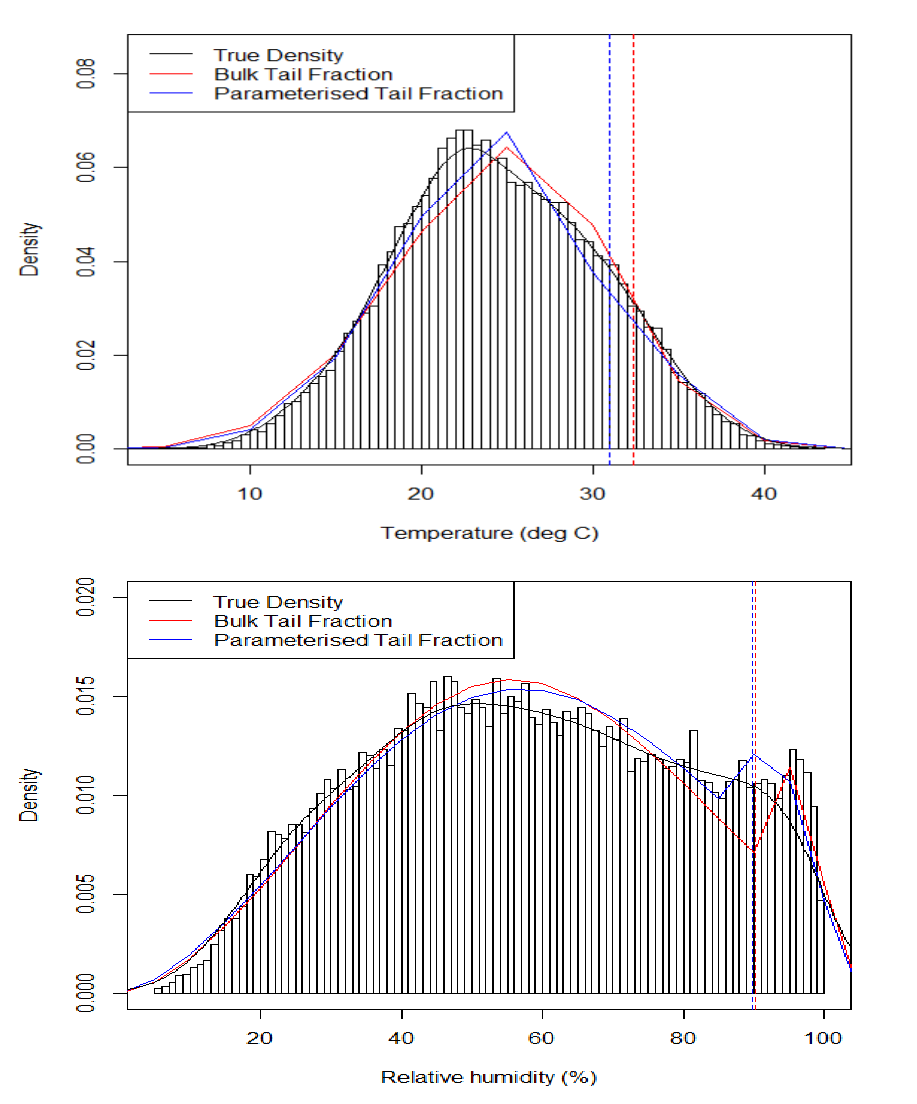
Figure 3. Top panel: Density function of temperature. Bottom panel: Density function of relative